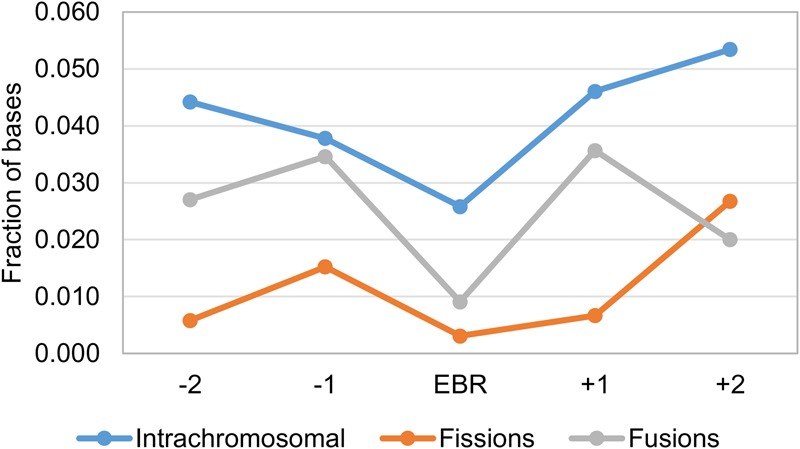
Average fraction of bases within conserved noncoding elements (CNEs) in avian EBRs and two flanking regions upstream (−) and downstream (+).